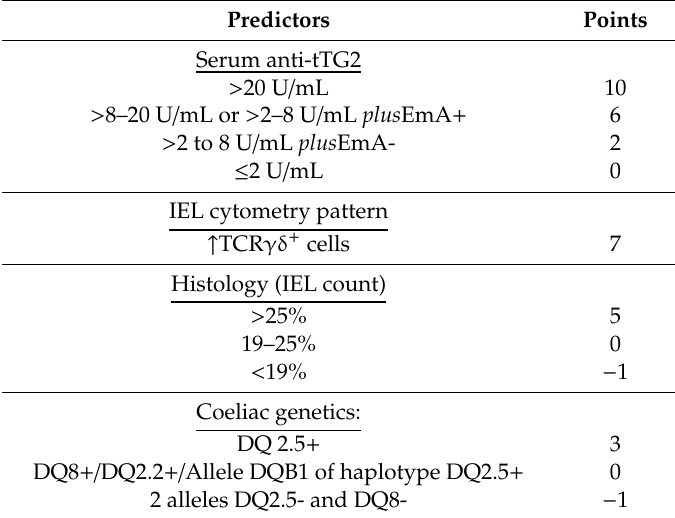
Table 3. Assigned points for the predictors and derived scoring system ( − 2 to 25